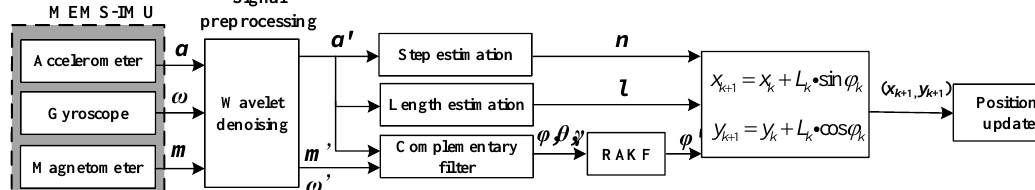
Figure 2. Pedestrian positioning system schematic. MEMS-IMU: microelectromechanical-inertial measurement unit; RAKF: robust adaptive Kalman